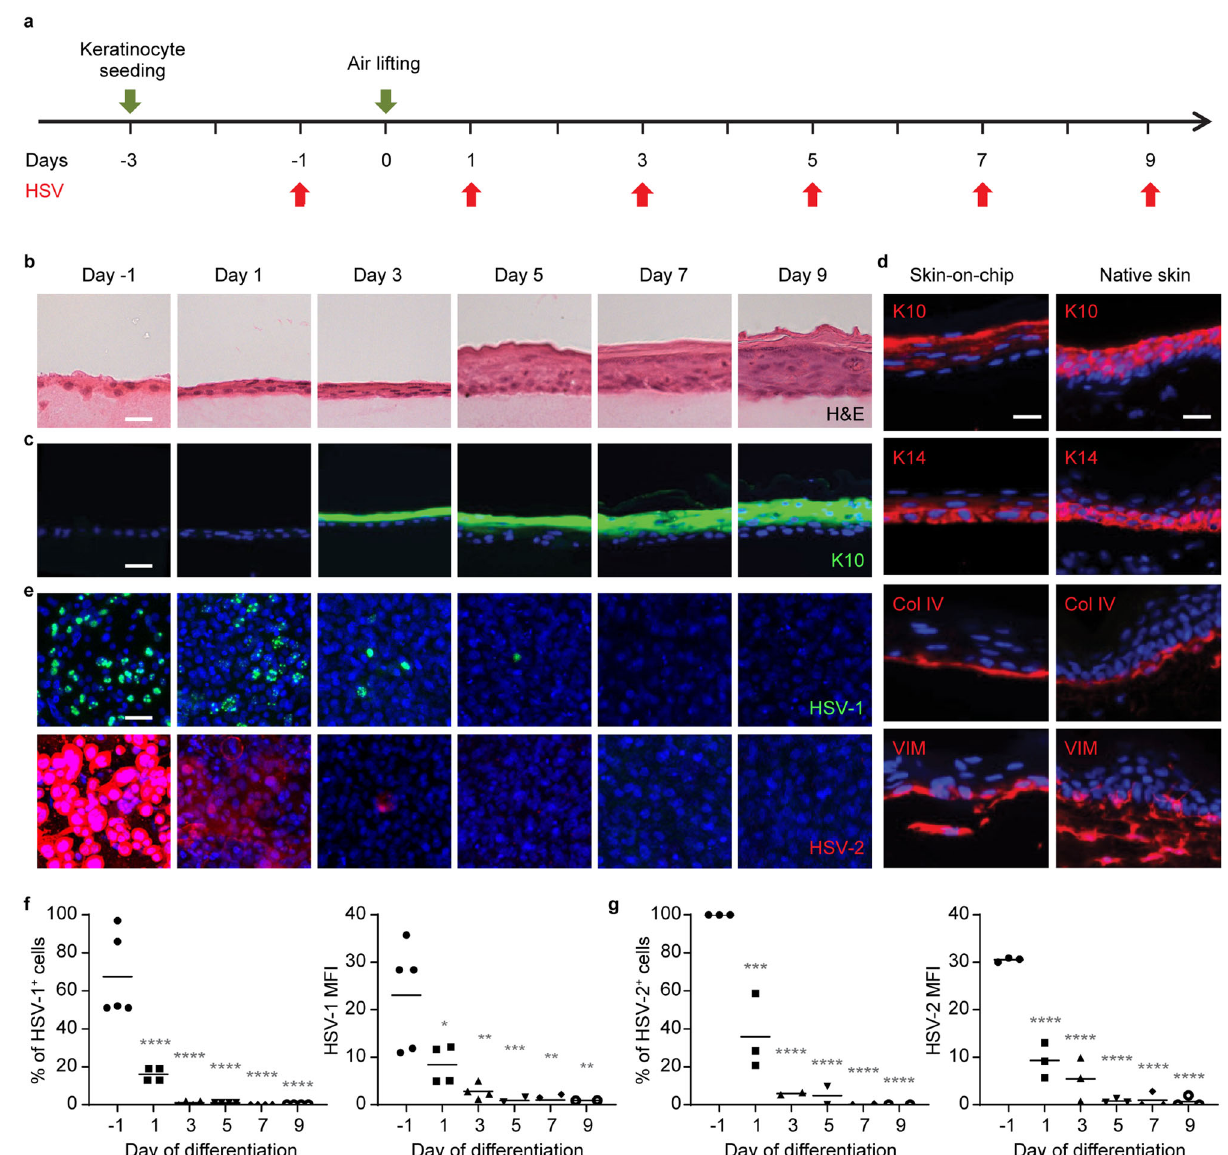
Fig. 2 | HSV infectivity at different stages of keratinocyte differentiation. a Schematic of HSV epidermalinfection during keratinocytes differentiationinthe skin-on-chip. Keratinocytes were infected with HSV (10 6 PFU) 1 day prior to air lifting or 1, 3, 5, 7, or 9 days post air lifting and examined 24h post infection. b Representative cross-section H&E images of the skin-on-chip (mock infected) at different time points before and after air lifting. Scale bar: 20 µ m. c Expression